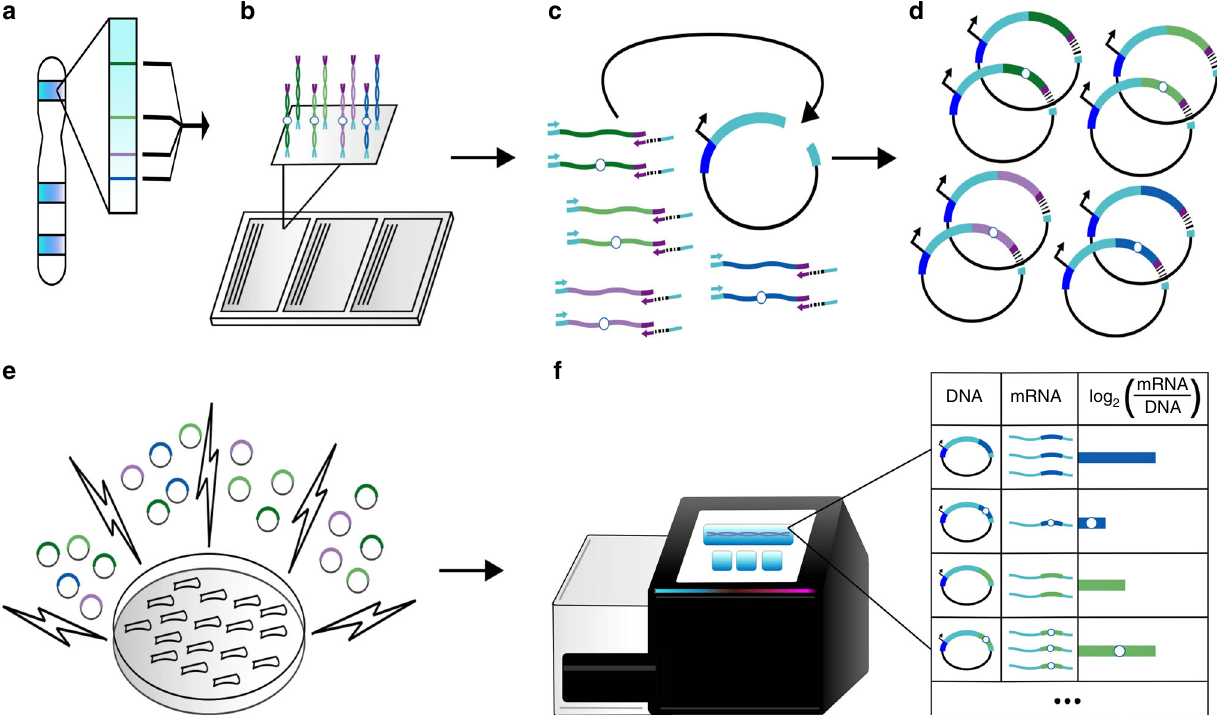
Fig. 1 Schematic of massively parallel reporter assay. a For each GWAS-lead SNP, we identi fi ed all SNPs in LD with r 2 > 0.8. Colored lines indicate SNPs in the same LD block. b For all SNPs, we extracted 196 nt of genomic sequence centered at the SNP, and separately synthesized the minor (hollow circle) and major alleles, fl anked by common adaptor sequences (cyan and purple). c , d We ampli fi ed our library from the array via PCR with primers directed at the common adaptors, in the process appending fi ve nt degenerate barcodes (black lines) and additional sequences homologous to the vector (cyan). We cloned our barcoded library of all major and minor alleles into the STARR-seq vector. Each putative regulatory region is cloned into the 3 ′ -UTR of a reporter gene (cyan) with a minimal promoter (dark blue). e We transfected our library into Saos-2 cells via electroporation. Forty-eight hours post transfection, we extracted RNA and DNA. f We determined the abundance of each allele – barcode combination in the mRNA and DNA population through sequencing. For each allele, we calculated one activity score as the average log 2 (RNA/DNA) across all independent measurements